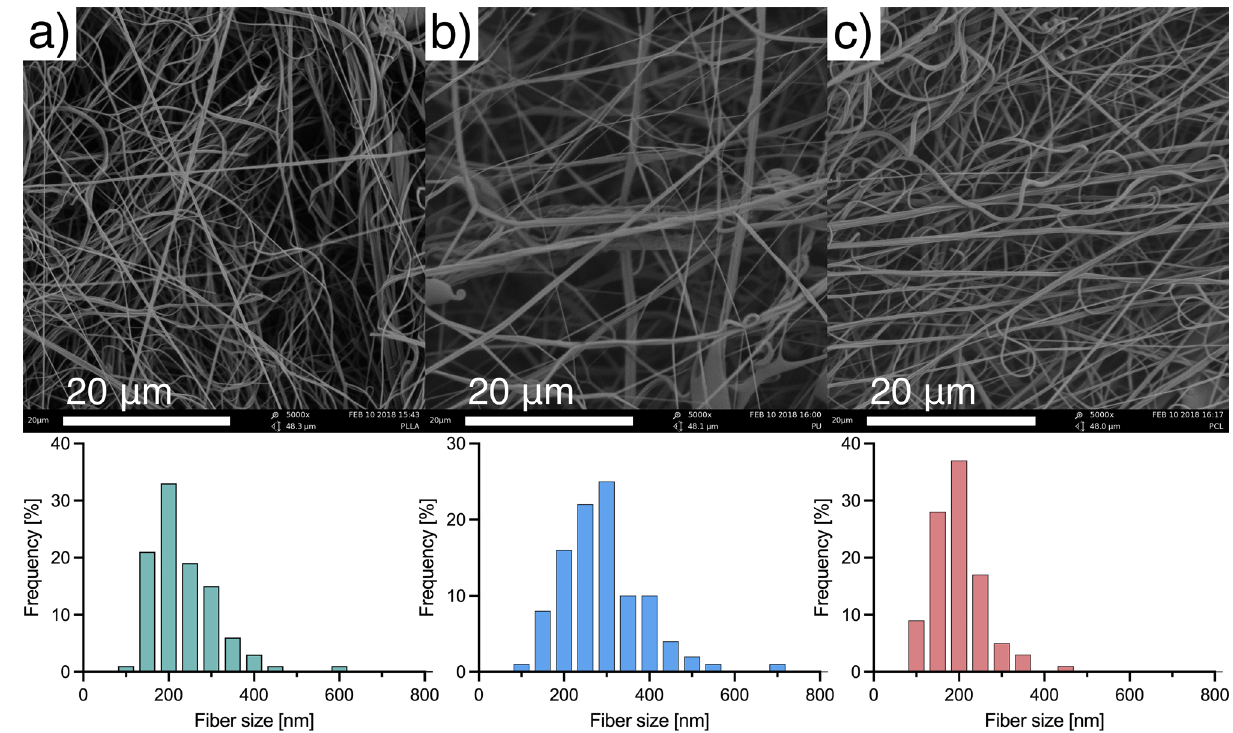
Figure 1. SEM images and fibers size distributions of ( a ) – PLLA; ( b ) – PU; ( c ) – PCL.